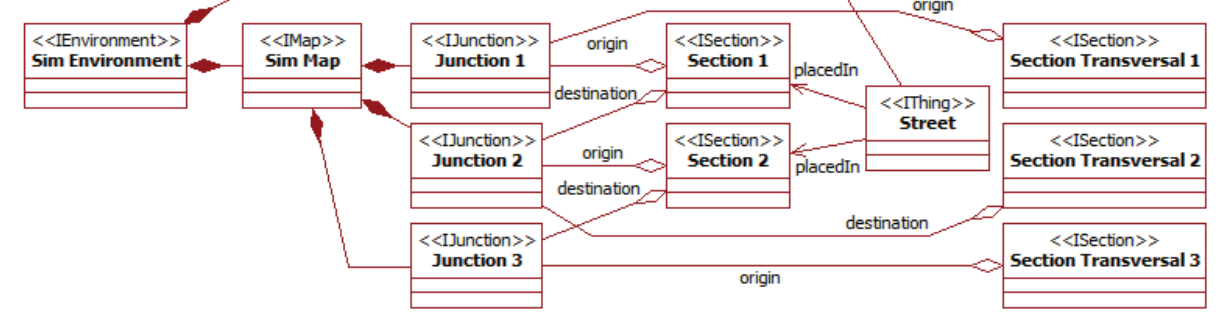
Figure 9. Intelligent traffic lights. Environment related